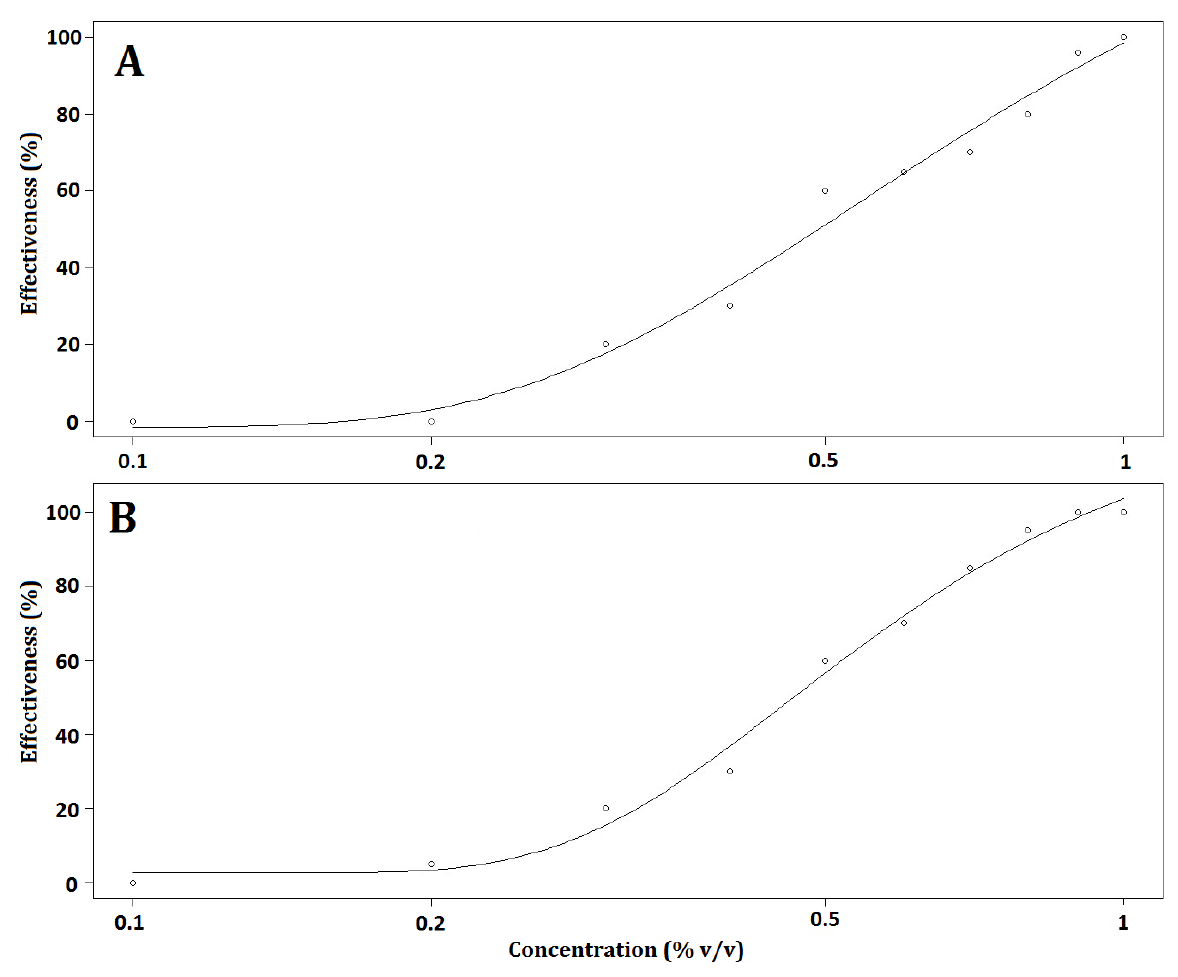
Figure 1. Dose-Response Curve for in vitro action of Panatop Immuno Active (A) and Panatop Immuno Active+ (B) towards Aphis pomi .